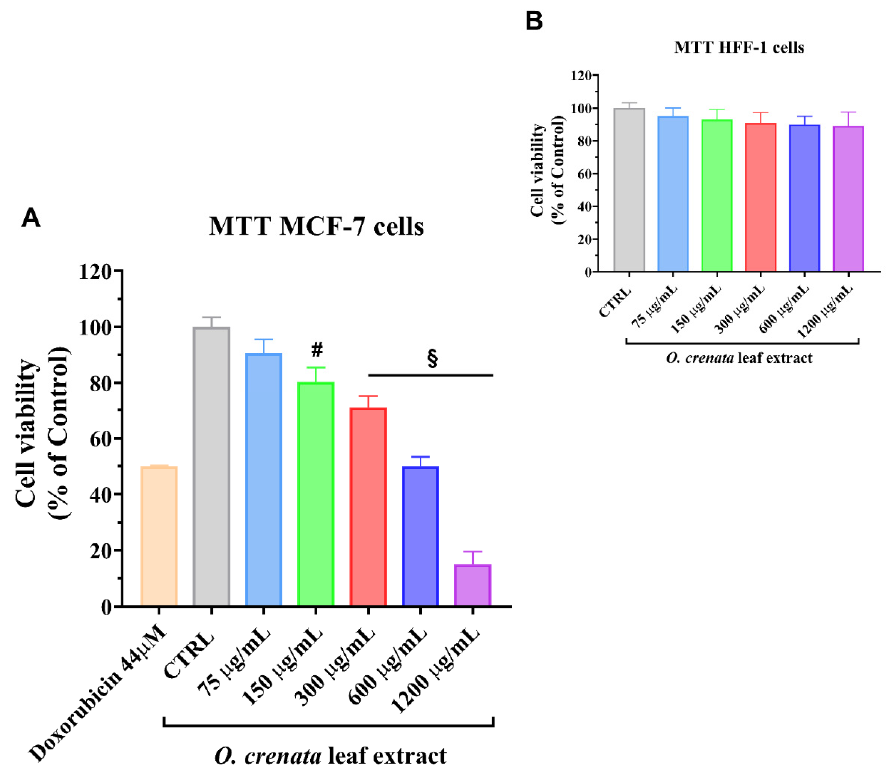
Figure 2. Cell viability of MCF-7 cells ( A ) and HFF-1 cells ( B ) untreated (control; CTRL) and treated for 24 h with increasing concentrations (from 75 to 1200 µ g/mL) of O. crenata leaf extract. Experiments were performed using Doxorubicin as a standard cytotoxic compound. The IC 50 of the standard agent was 44 ± 0.3 µ M for MCF-7 cells and >100 µ M for HFF-1 cells (not shown). Values are the mean ± SD of four experiments in triplicate. § p < 0.0001, # p < 0.001 vs. untreated control.